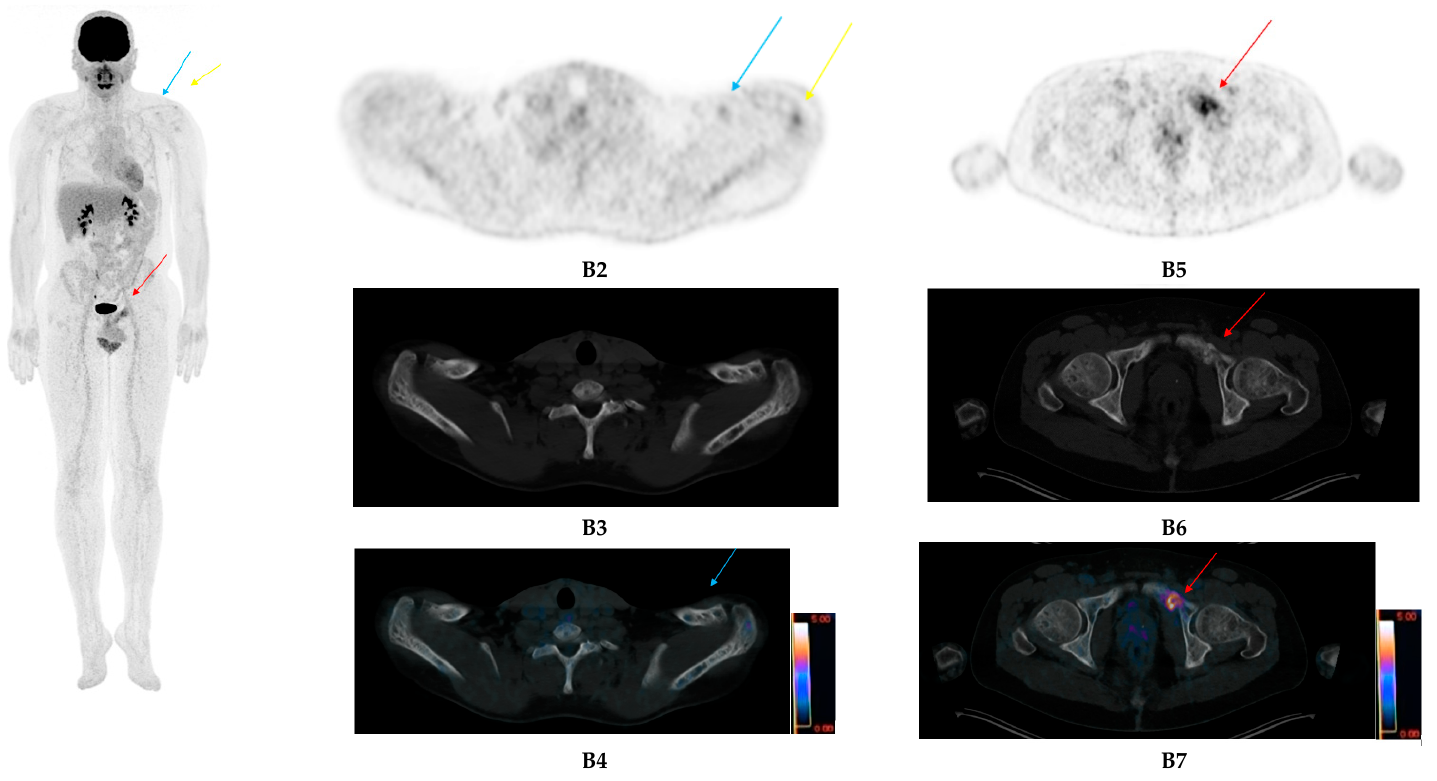
Figure 1. IgGk multiple myeloma (MM) patient at first relapse after autologous stem cell transplantation. Positron emission tomography with computed tomography using 18F-deoxyglucose (FDG-PET/CT) images before therapy ( A ) show several focal bone lesions (FLs) in maximum intensity projection (MIP) images ( A1 ), especially the left pelvic FL (Red arrow; ( A2 ) PET images; ( A3 ): computed tomography (CT) images; ( A4 ) fused images, maximum standardized uptake value (SUV max : 9)) and left collarbone (Blue arrow)/acromion FLs (Yellow arrow) in axial slices ( A5 / A6 ). Note the numerous osteolytic bone lesions without corresponding increased FDG uptake in the CT images as this patient had been pretreated, and morphological abnormalities may persist a long time after. FDG-PET/CT images after therapy ( B ) shows overall decrease in FL uptake in MIP images ( B1 ). Whilst the left collarbone(Blue arrow)/acromion FL (Yellow arrow) residual uptake ( B1 / B2 / B3 / B4 ) is lower than the hepatic background (Deauville 3), the left pelvic FL (Red arrow) residual uptake ( B1 / B5 / B6 / B7 ) has decreased but is still higher than the hepatic background (Deauville 4, SUV max : 6) revealing a partial metabolic response.